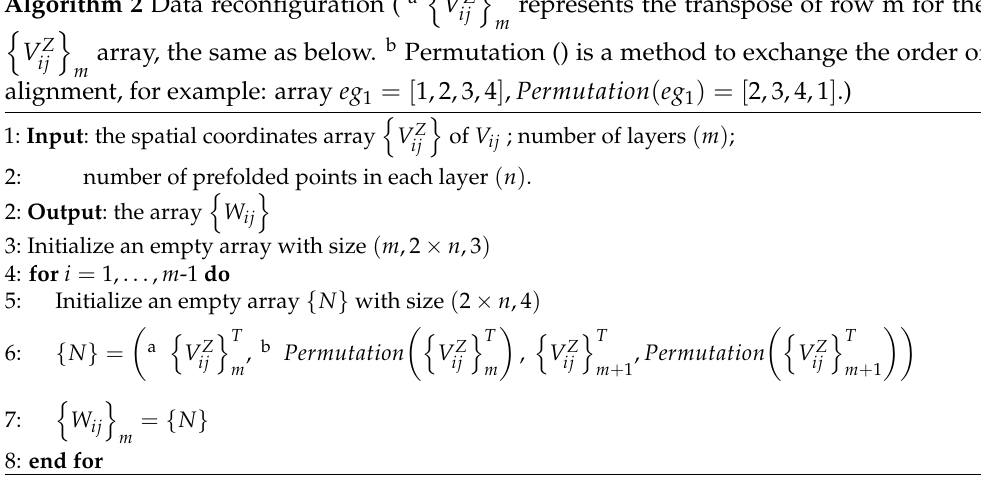
(cid:110) (cid:111) T V Z represents the transpose of row m for ij m